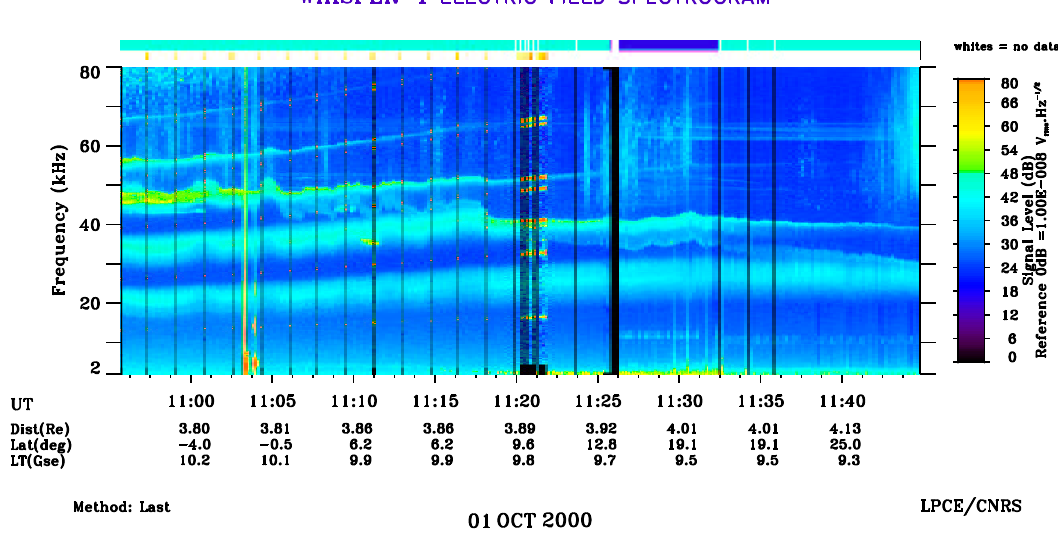
Fig. 7. Dynamic spectrogram obtained from Whisper data on 1 October 2000 from Cluster 1 Rumba. The frequency bandwidth of the emissions detected between the harmonic of the gyrofrequency varies from broad band to narrow band during this period. They correspond to the Fqs triggered in the active mode by Whisper. The plasma frequency is identified with the low frequency cutoff of the emission, which decreases in frequency from about 45kHz at 11:00UT down to 30kHz at